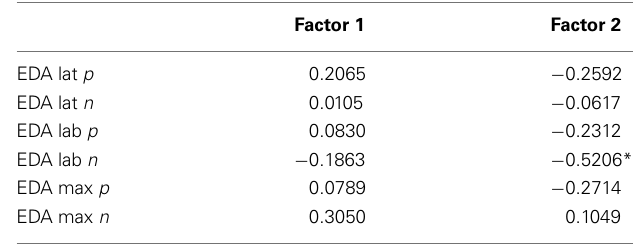
Table 2 | Correlation indices (rho) between PCL-R scores and EDA measures for unpleasant stimuli .